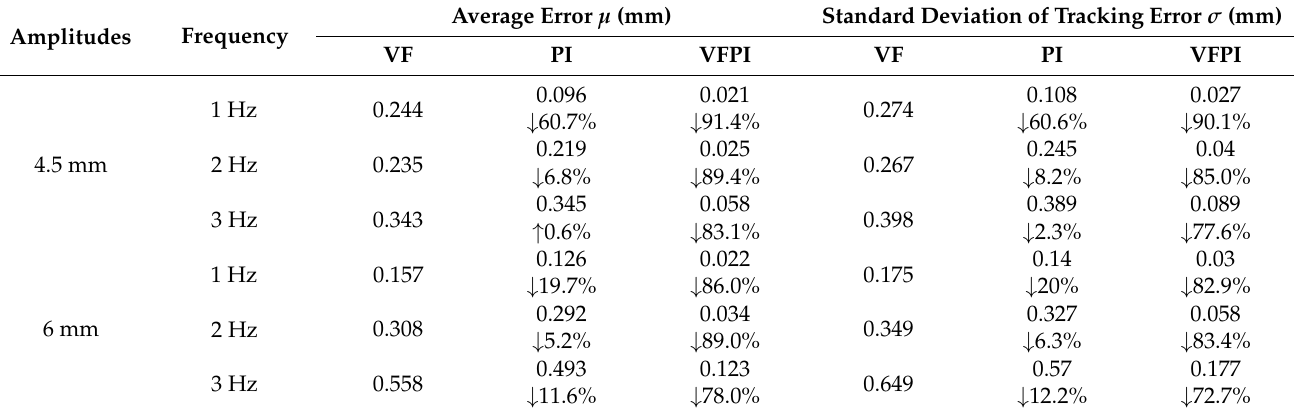
Table 4. Comparison between the tracking errors of the three